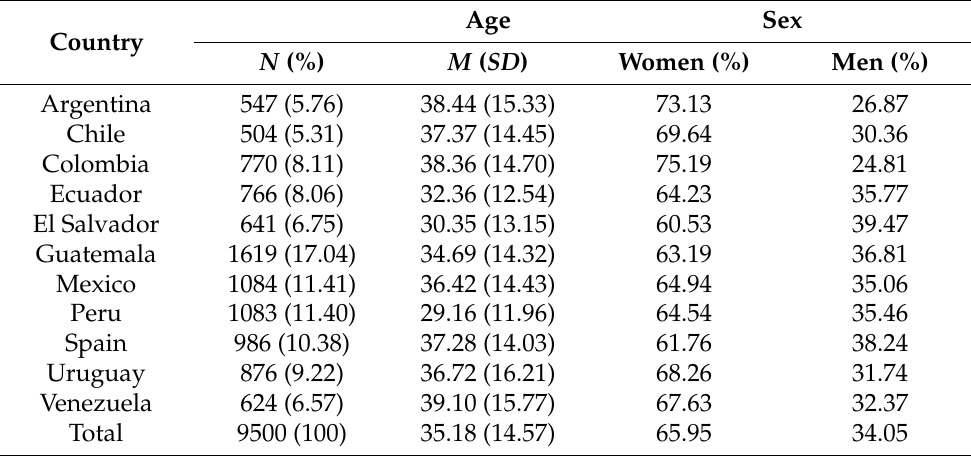
Table 1. Number of participants, mean age, and sex distribution by country.